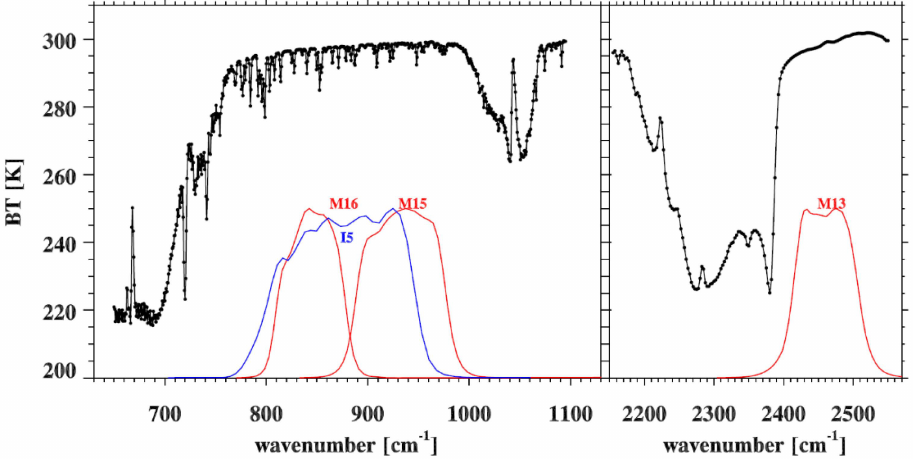
Figure 1. CrIS spectra from the LWIR and SWIR bands (bands 1 and 3) and the VIIRS spectral response functions of I5, M13, M15, and M16